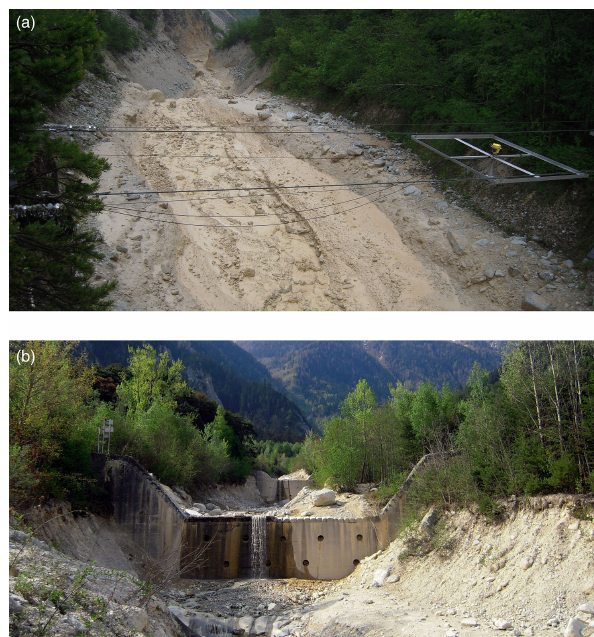
Figure 2. Debris-flow EWS Illgraben (Canton VS, Switzerland): (a) the debris-flow detection system in the upper part of the catch- ment (b) the lower part of the catchment with warning